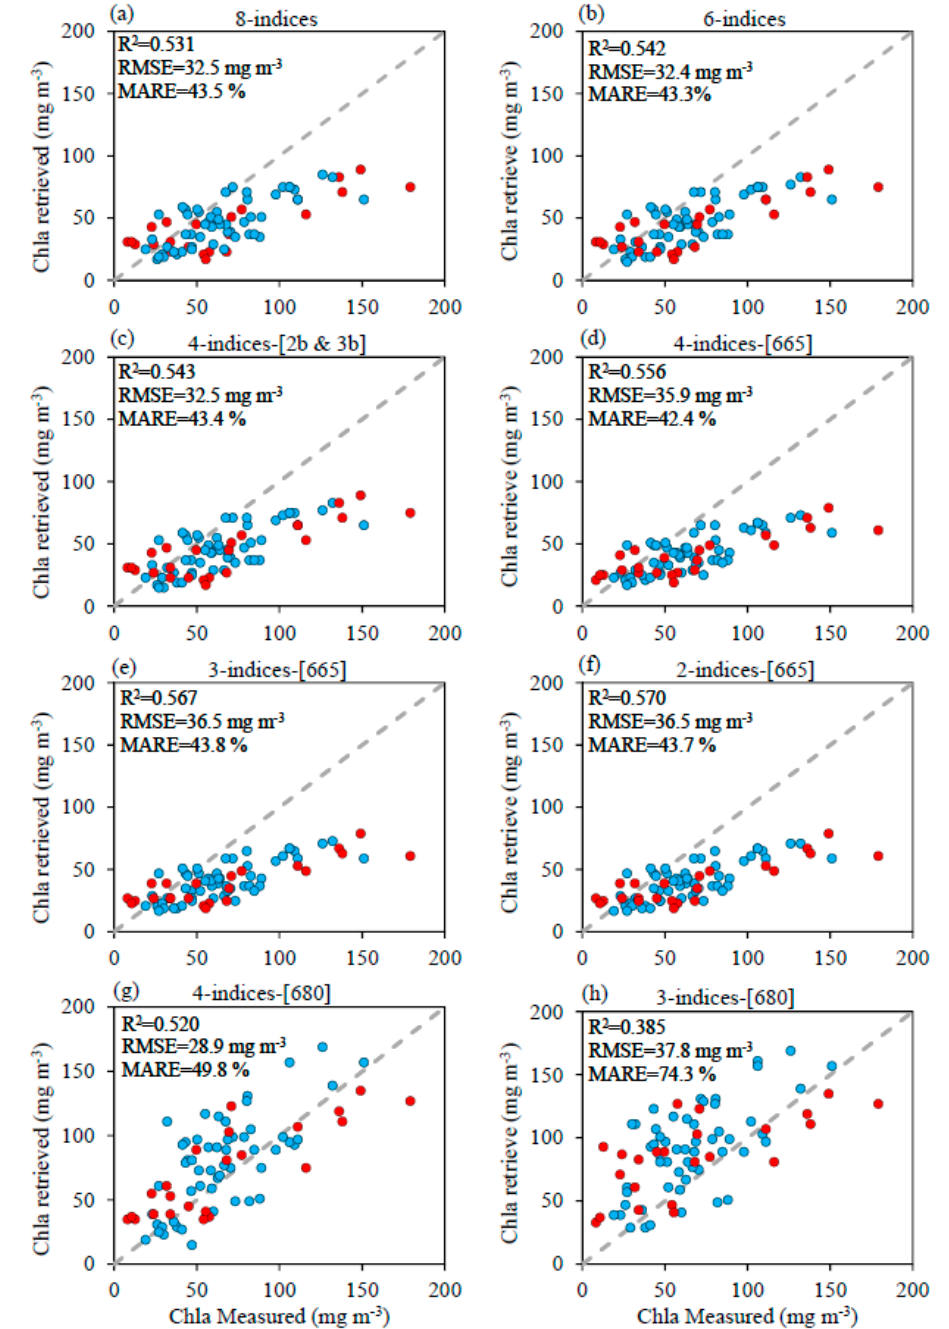
Figure 8. Validation plots between Chla measured in Lake Kasumigaura (77 stations matched Medium Resolution Imaging Spectrometer (MERIS) images and collected during 2002–2012) and retrieved Chla from different algorithms’ combinations assessed for MAIN-LUT. The red and blue dots highlighted stations that matched MERIS images at same day and one-day differences, respectively. Algorithms used in each combination from ( a ) to ( h ) were mentioned in Table 4.